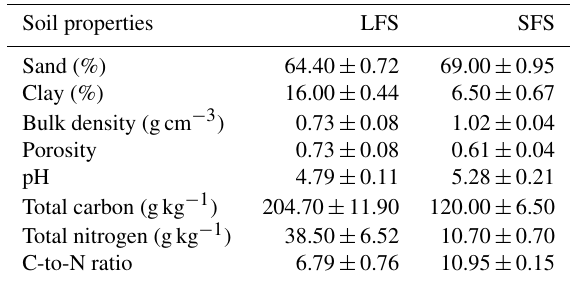
Table 1. Soil properties (0–10cm) in the LFS and SFS. Values are mean ±